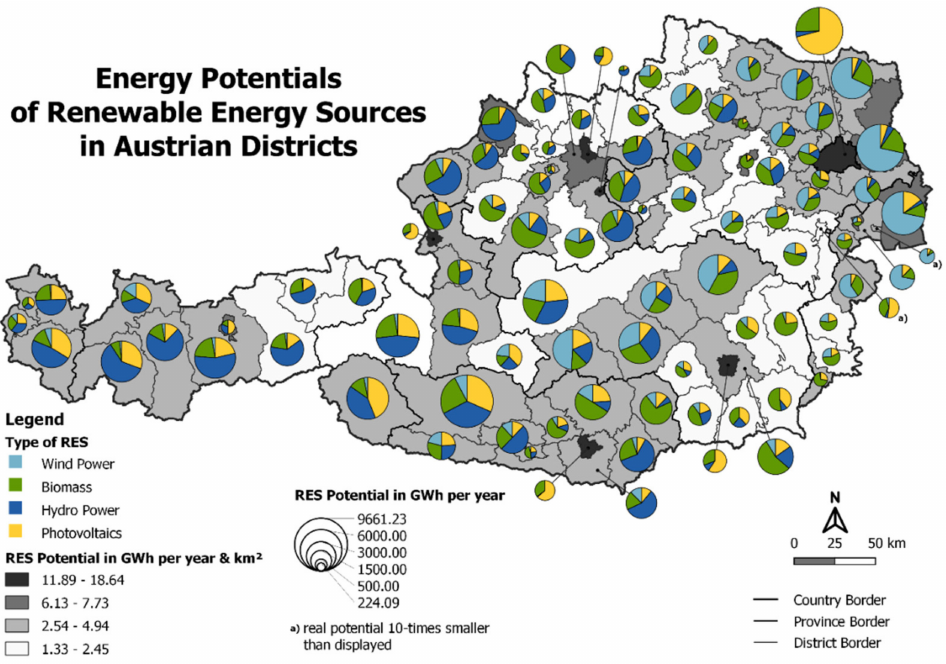
Figure 1. Technical energy potentials of RES per Austrian district, derived from